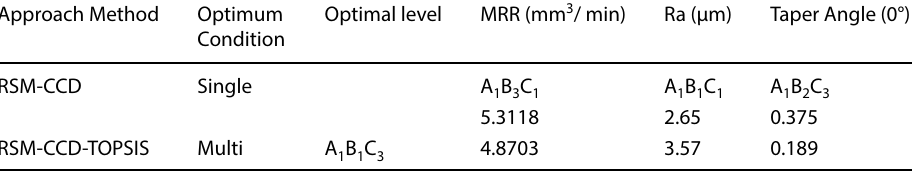
Table 13 Confirmation experimental